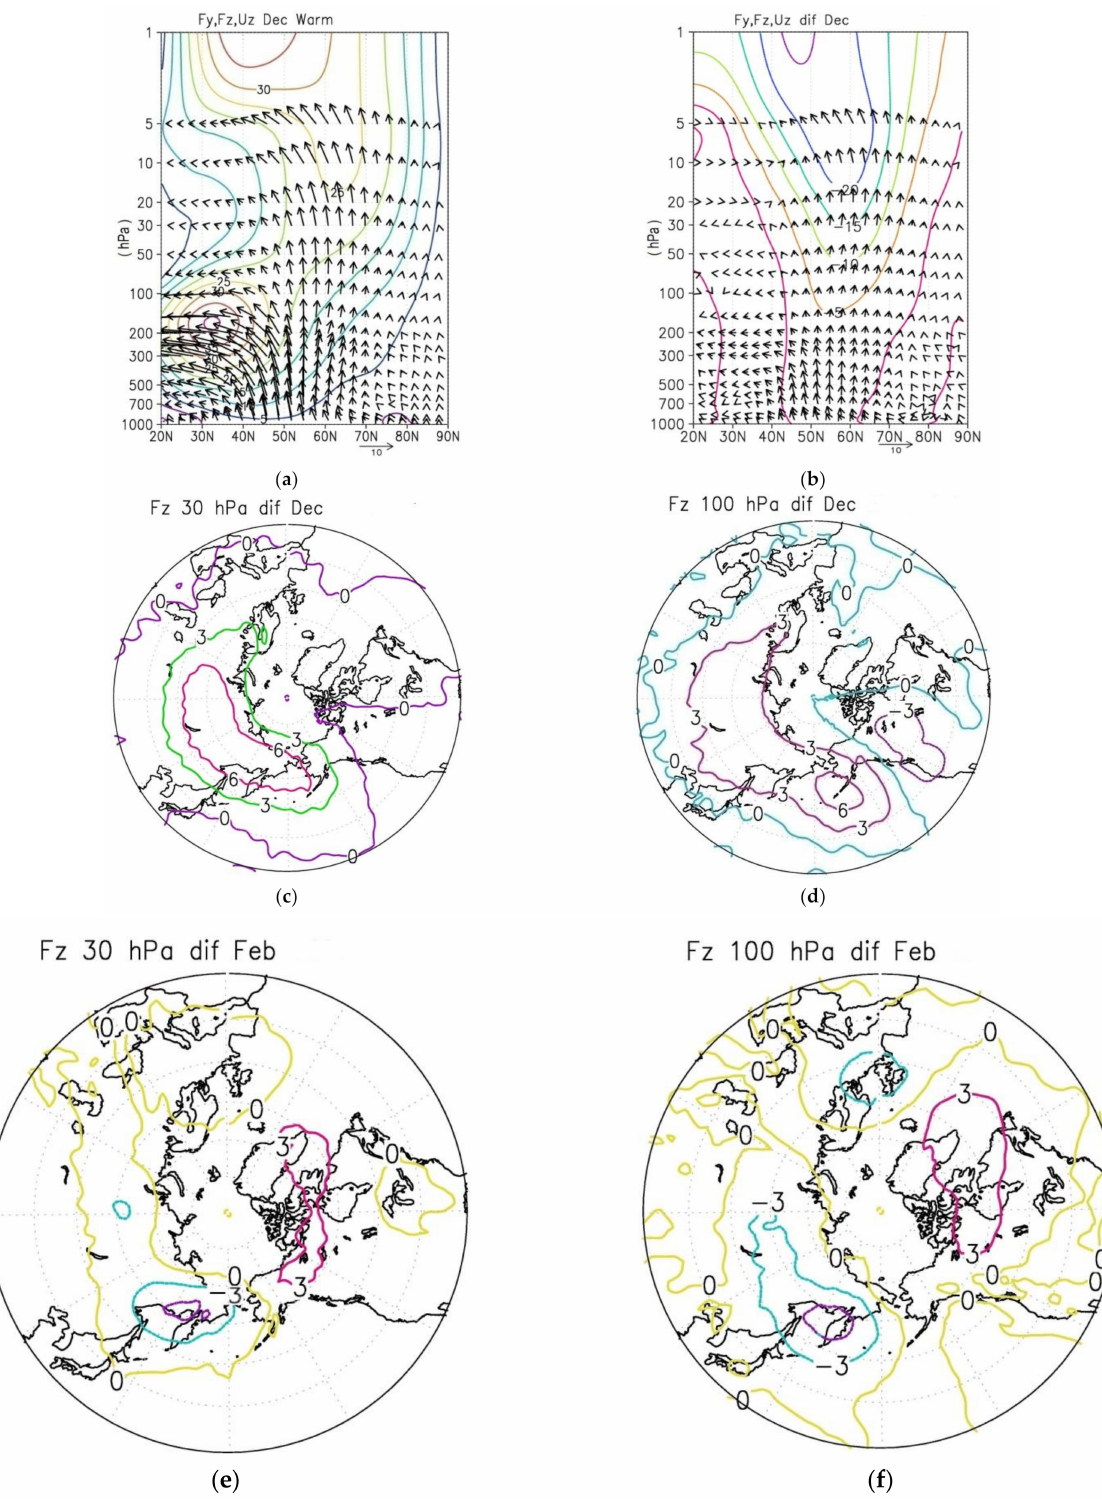
Figure 9. Altitude-latitude cross section of Plumb vectors Fy, Fz [m 2 /s 2 ] and zonal mean zonal wind in December for the “warm” winter composite ( a ). Difference of these parameters between the “warm” and “cold” winters ( b ). Similar difference of Plumb flux vertical component Fz in December ( c , d ) and in February ( e , f ) between the “warm” and “cold” winters at pressure level 30 hPa ( c , e ) and 100 hPa ( d , f ). Vertical component Fz is multiplied by